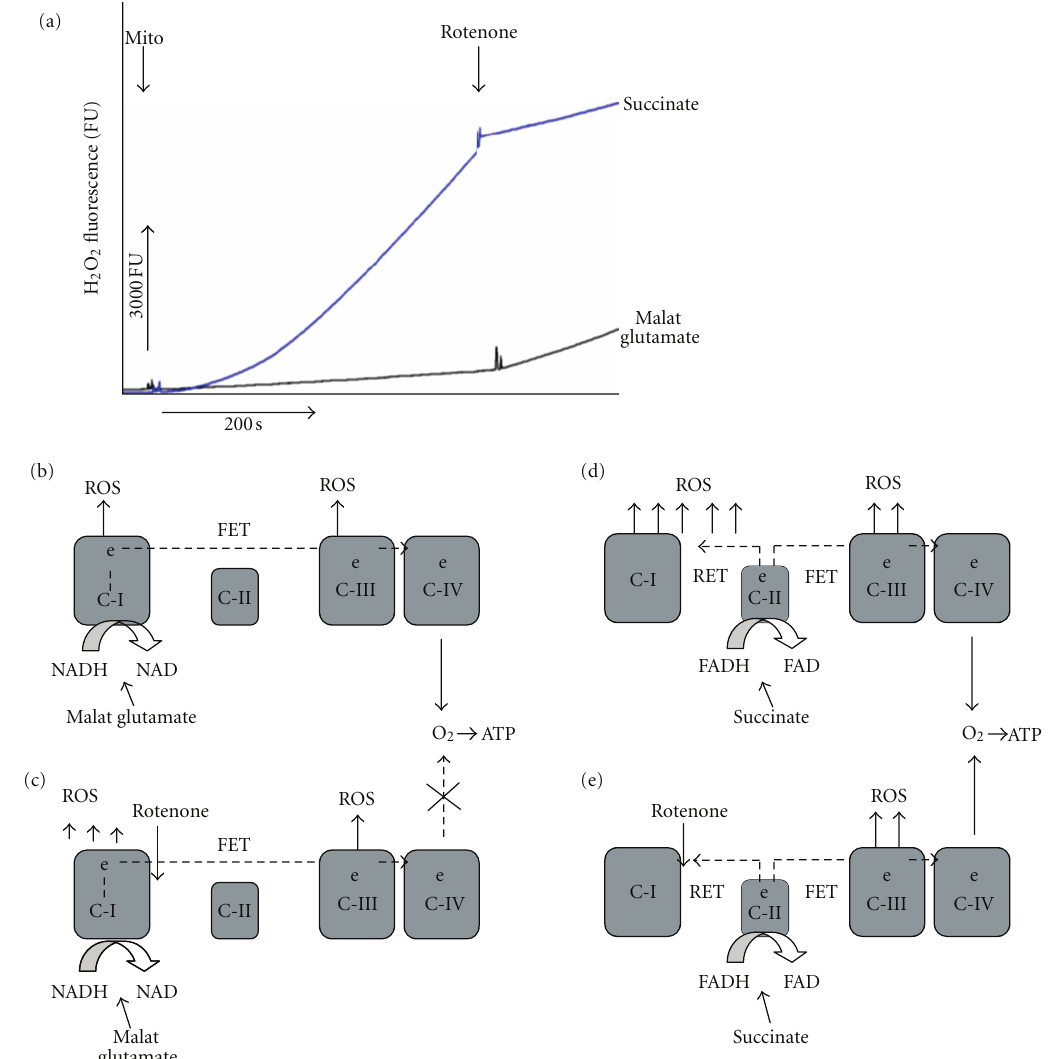
Figure 2: (a) H 2 O 2 emission rate from brain mitochondria isolated from p10 na¨ıve mouse and supported either with succinate (FAD-linked substrate) or malate-glutamate (NAD-linked substrates). Time-points when mitochondria (mito, 0.05 mg/mL) or rotenone (1 μ M) were added are indicated. Cerebral nonsynaptic mitochondria were isolated and mitochondrial H 2 O 2 fluorescence was measured using Amplex- ultra-red and horse radish peroxidase assay as described in [31]. (b–e), a schematic mechanism for ROS generation in MRC fueled with NAD-linked substrate, before (b) and after inhibition of complex I with rotenone (c), or FAD-linked substrate, before (d) and after rotenone supplementation (e). RET: reverse electron trasport, FET: forward electron